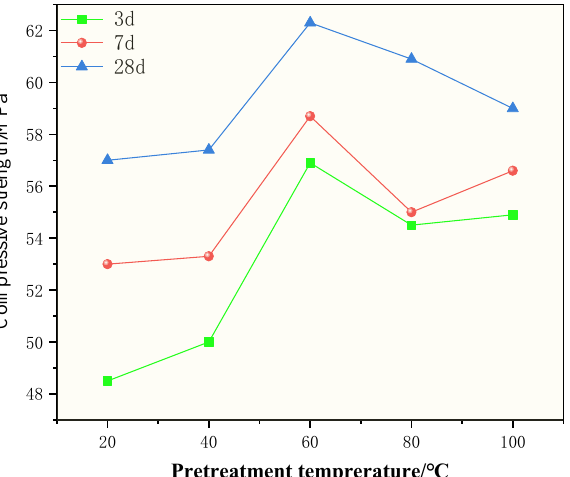
Figure 4. Effect of pretreatment temperature of CDWC on compressive strength of CDWGC.